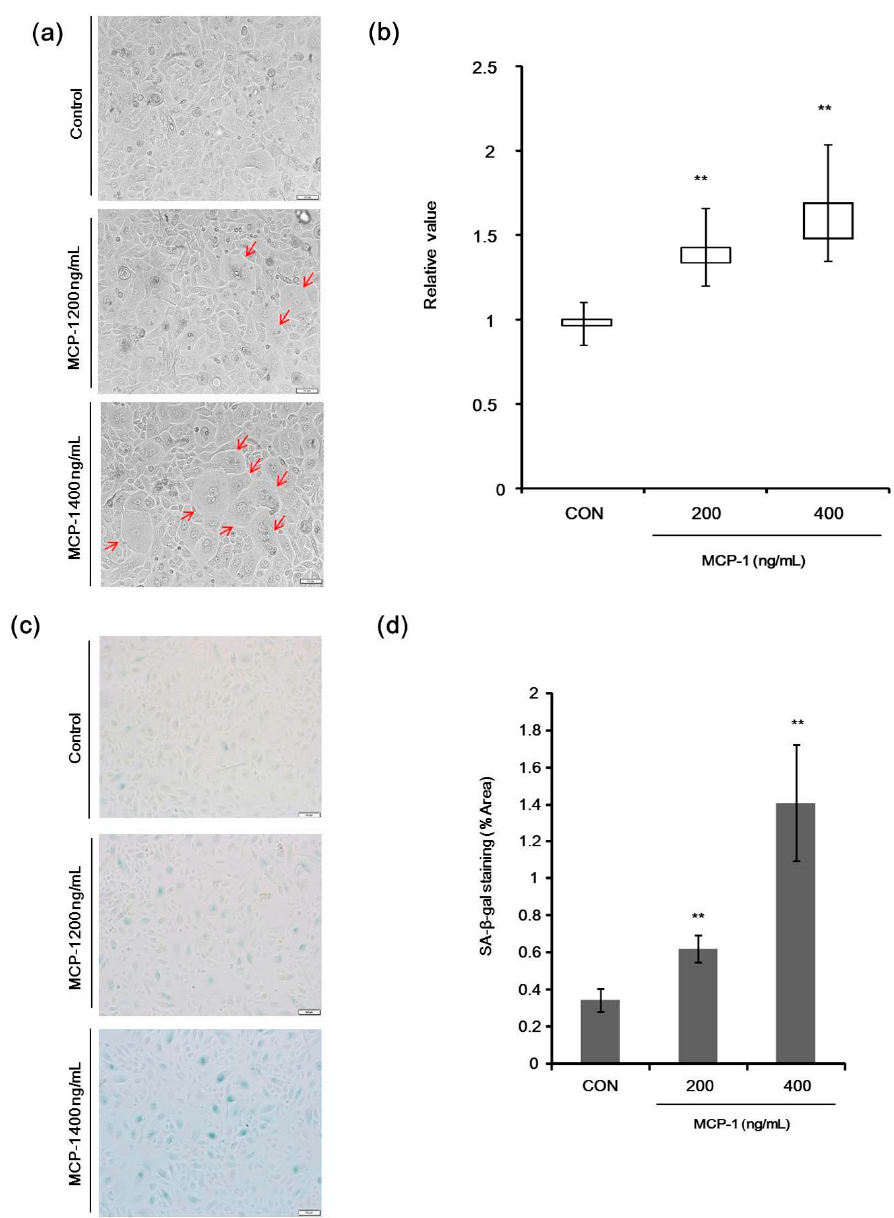
Figure 4. ( a ) Morphological changes in NHKs following treatment with MCP-1 (200 or 400 ng/mL) were observed (arrow) (scale bar: 50 µm); ( b ) nuclear length was calculated using the Image J software on bright field microscope image. Three fields were selected to calculate nuclear size (10 cells per field). Median, interquartile range, minimum, and maximum are depicted by box plots; ( c ) effects of MCP-1 on NHK senescence were evaluated by Senescence-Associated Beta-Galactosidase (SA- β -Gal) staining. NHKs were seeded at the same density in 6-well plates and were stained for SA- β -Gal, using a commercial histochemical staining kit. SA- β -Gal activity (blue lights) was increased in the presence of 200–400 ng/mL MCP-1 for 72 h (scale bar: 50 µm); ( d ) five fields were selected to calculate the SA- β -Gal staining area in each group and the average was taken as the total area. The data are presented as the mean ± SD ( n = 3). ** p < 0.01 by the Student’s t -test.